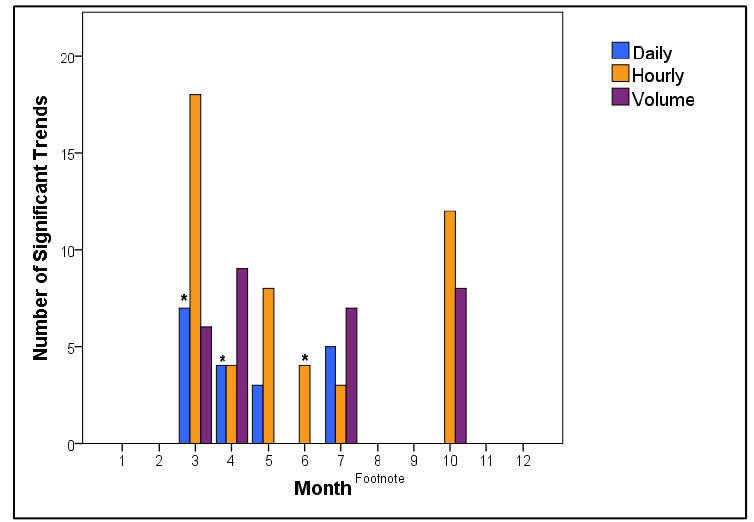
Figure 3. The number of significant trends found for months meeting field significance thresholds at 10%. * indicates spatial autocorrelation detected for month and scale.